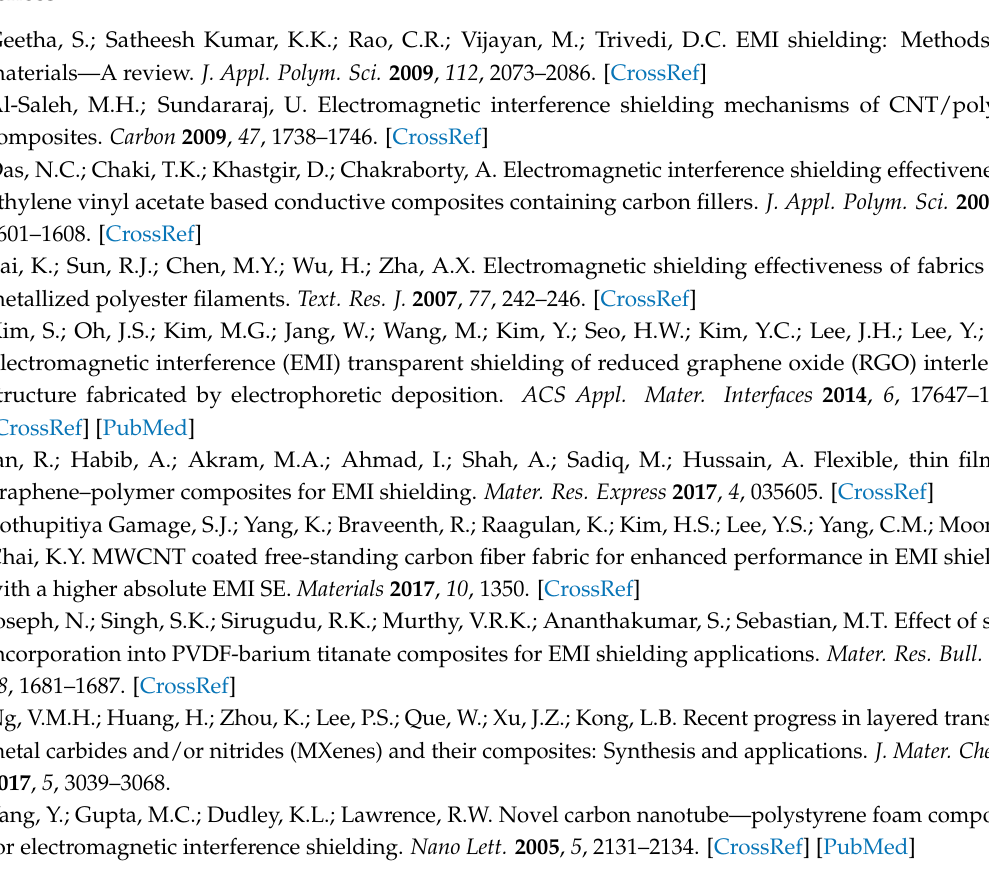
s1, Figure S1: EMI shielding sample loading; Figure S2: Cross section of SEM image; Figure S3: EDX and mapping; Figure S4: Normalized curve of Raman spectrum; Table S1: Comparison of EMI SE with thickness; Table S2: Comparison of maximum (MAX), minimum (MINI), average (AVE) shielding, SSE and SSE/t of composite in each